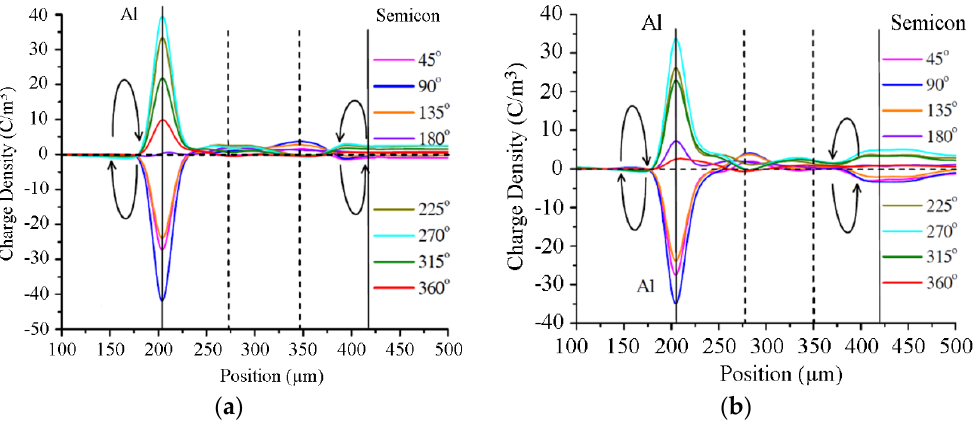
Figure 19. AC volt-on space charge behaviour in a sinusoidal cycle at 120 min for oil immersed paper sample (60 kV/mm, peak-peak) [36]. ( a ) new oil immersed paper; ( b ) 22 days’ aged oil immersed paper.